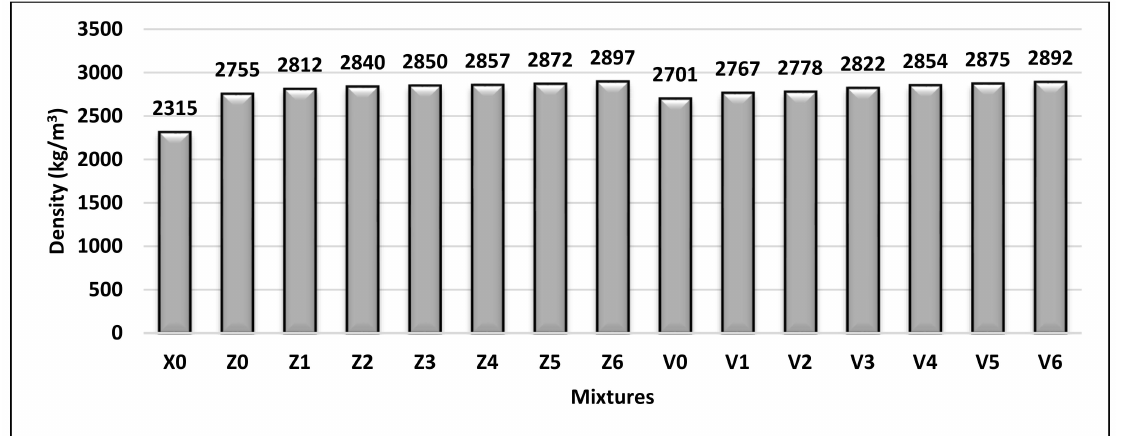
Figure 13. Hardened density of all mixtures (kg/m 3